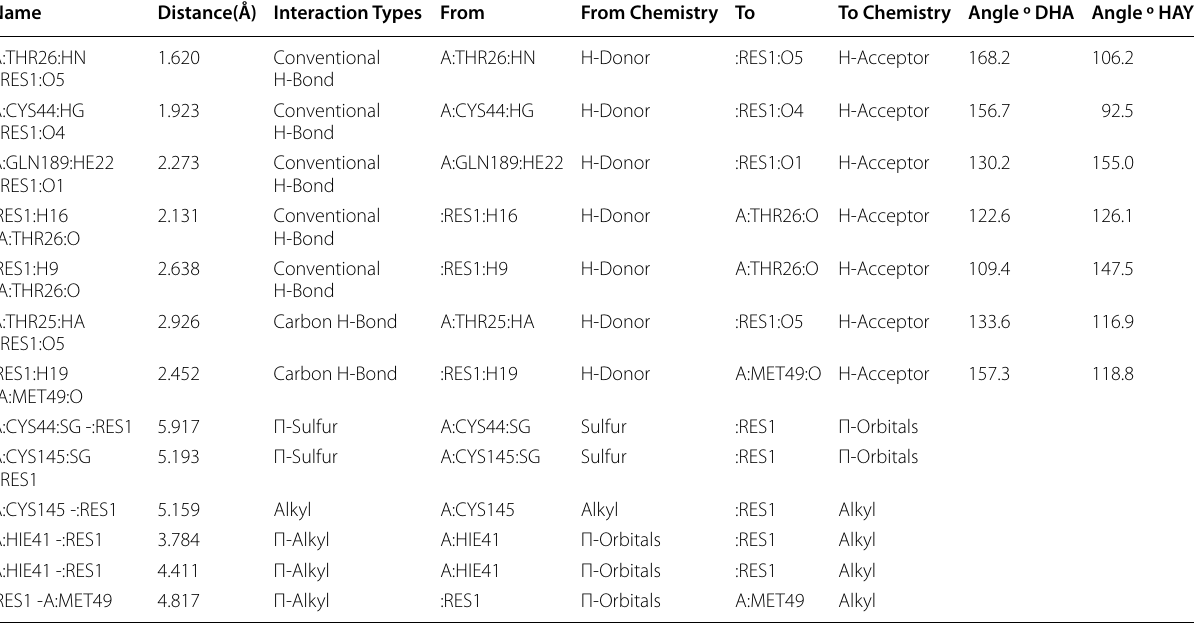
Table 4 Interaction types with surrounding amino acids of SARS CoV 2 Main Protease (PDB ID: 6XBH) with inhibitor Index number 46 Name Distance(Å) Interaction Types From From Chemistry